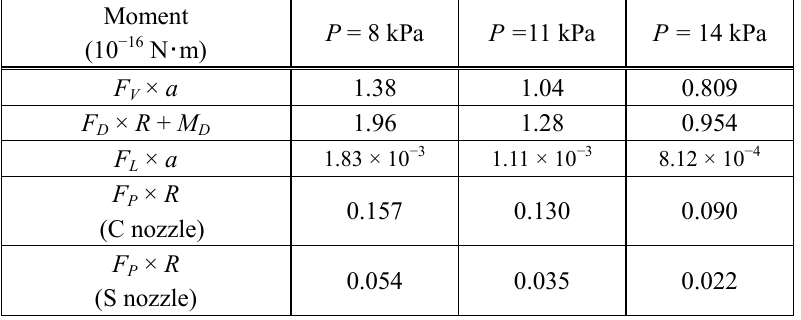
Table 2 Adhesive and removal moment at the moment balance condition for each pressure P